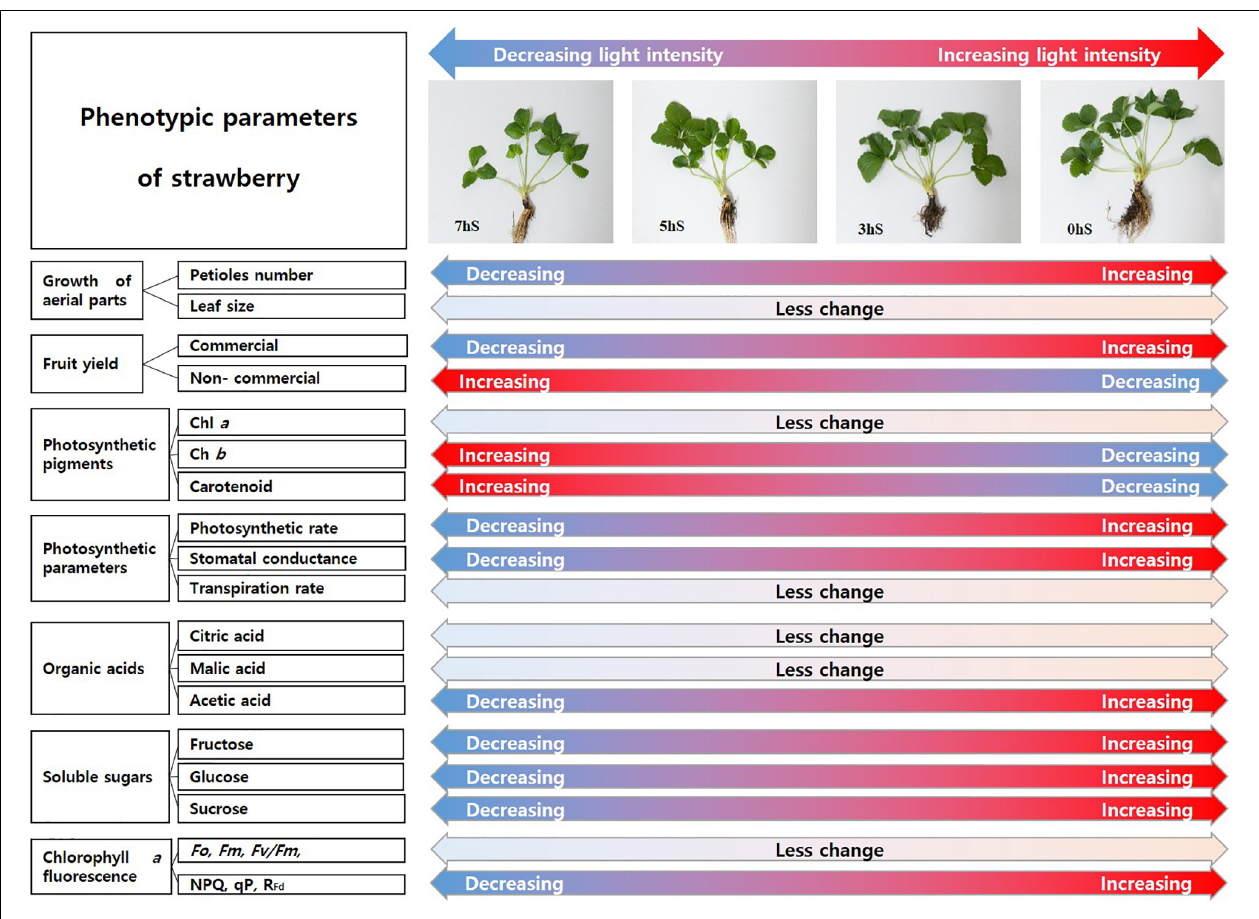
FIGURE 8 | Schematic diagram of the degree of changes of phenotypic parameters of strawberry ( Fragaria × ananassa ) plants according to light intensity. 0 hS, non-shading treatment (control); 3 hS, three hours of shading until 10:00; 5 hS, five hours of shading until 12:00; 7 hS, seven hours of shading until